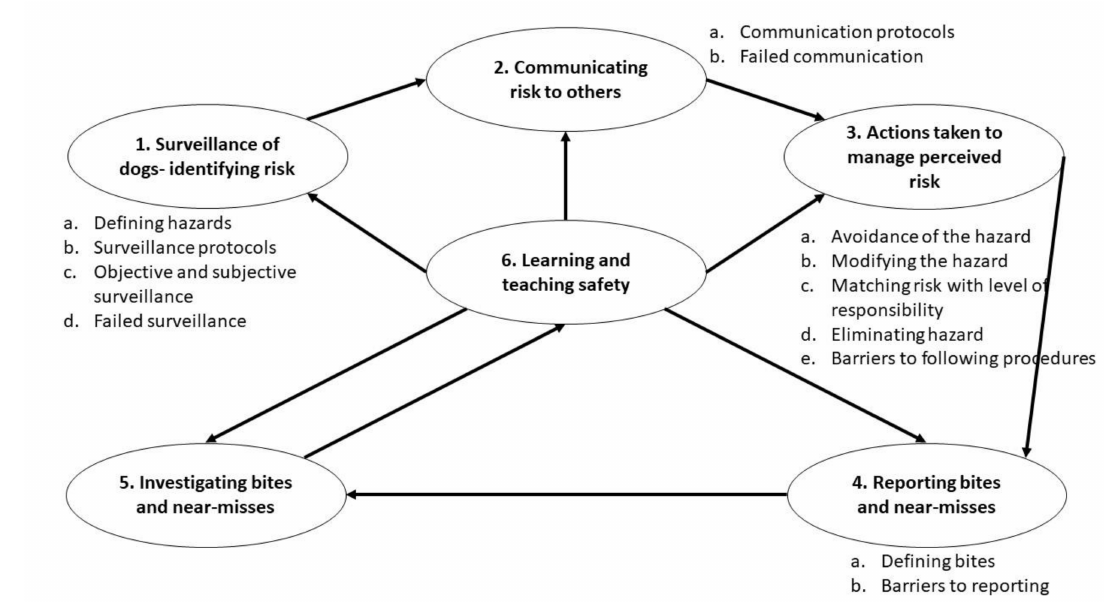
Figure 1. Schematic representation of the identified themes relating to dog bite prevention within work contexts. Each theme (1–6) corresponds to consecutive and co-dependent step of bite prevention. Sub-theme (a-e) are listed next to the